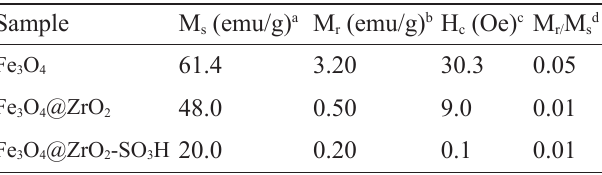
Table 1. Magnetic properties of MNPs, Fe 3 O 4 @ZrO 2 and Fe 3 O 4 @ ZrO 2 -SO 3 H.